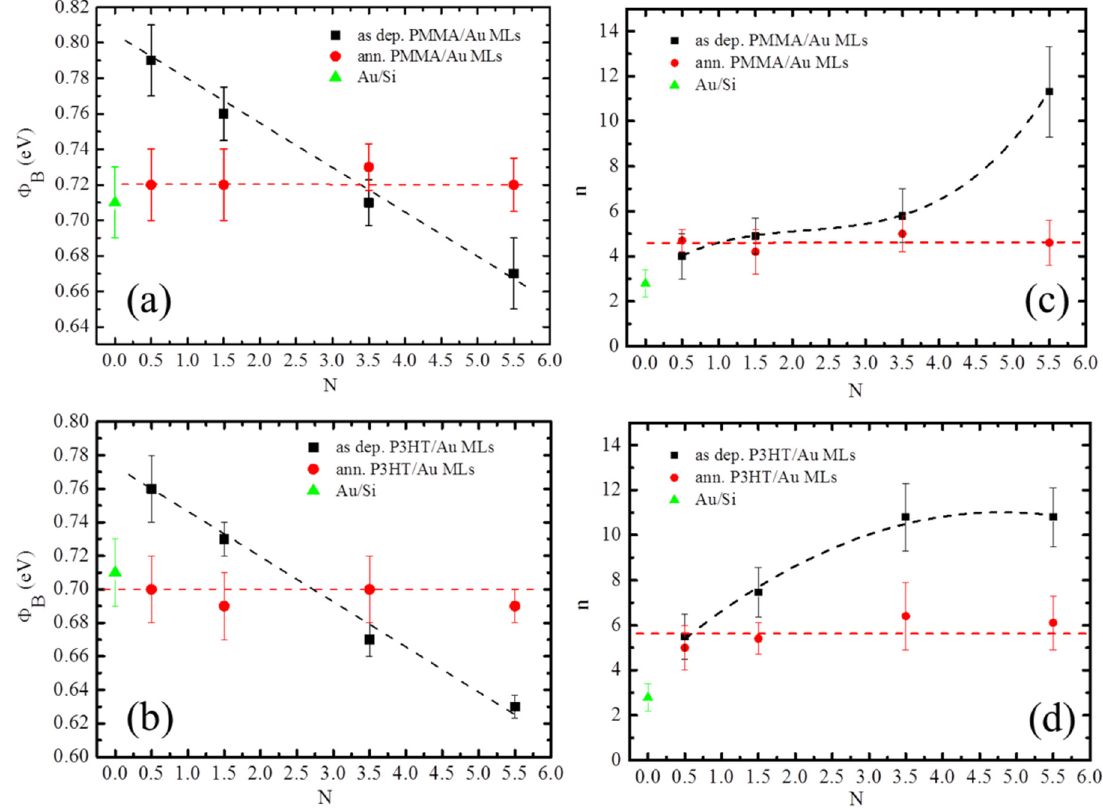
Figure 21. Graphics of barrier height vs . number of bilayers for as deposited and annealed PMMA based HyMLs ( a ) and for P3HT based HyMLs ( b ). Graphics of ideality factor vs. number of bilayers for as deposited and annealed PMMA based HyMLs ( c ) and for P3HT based HyMLs ( d ). (Reproduced with permission from [80], Copyright AIP Publishing LLC